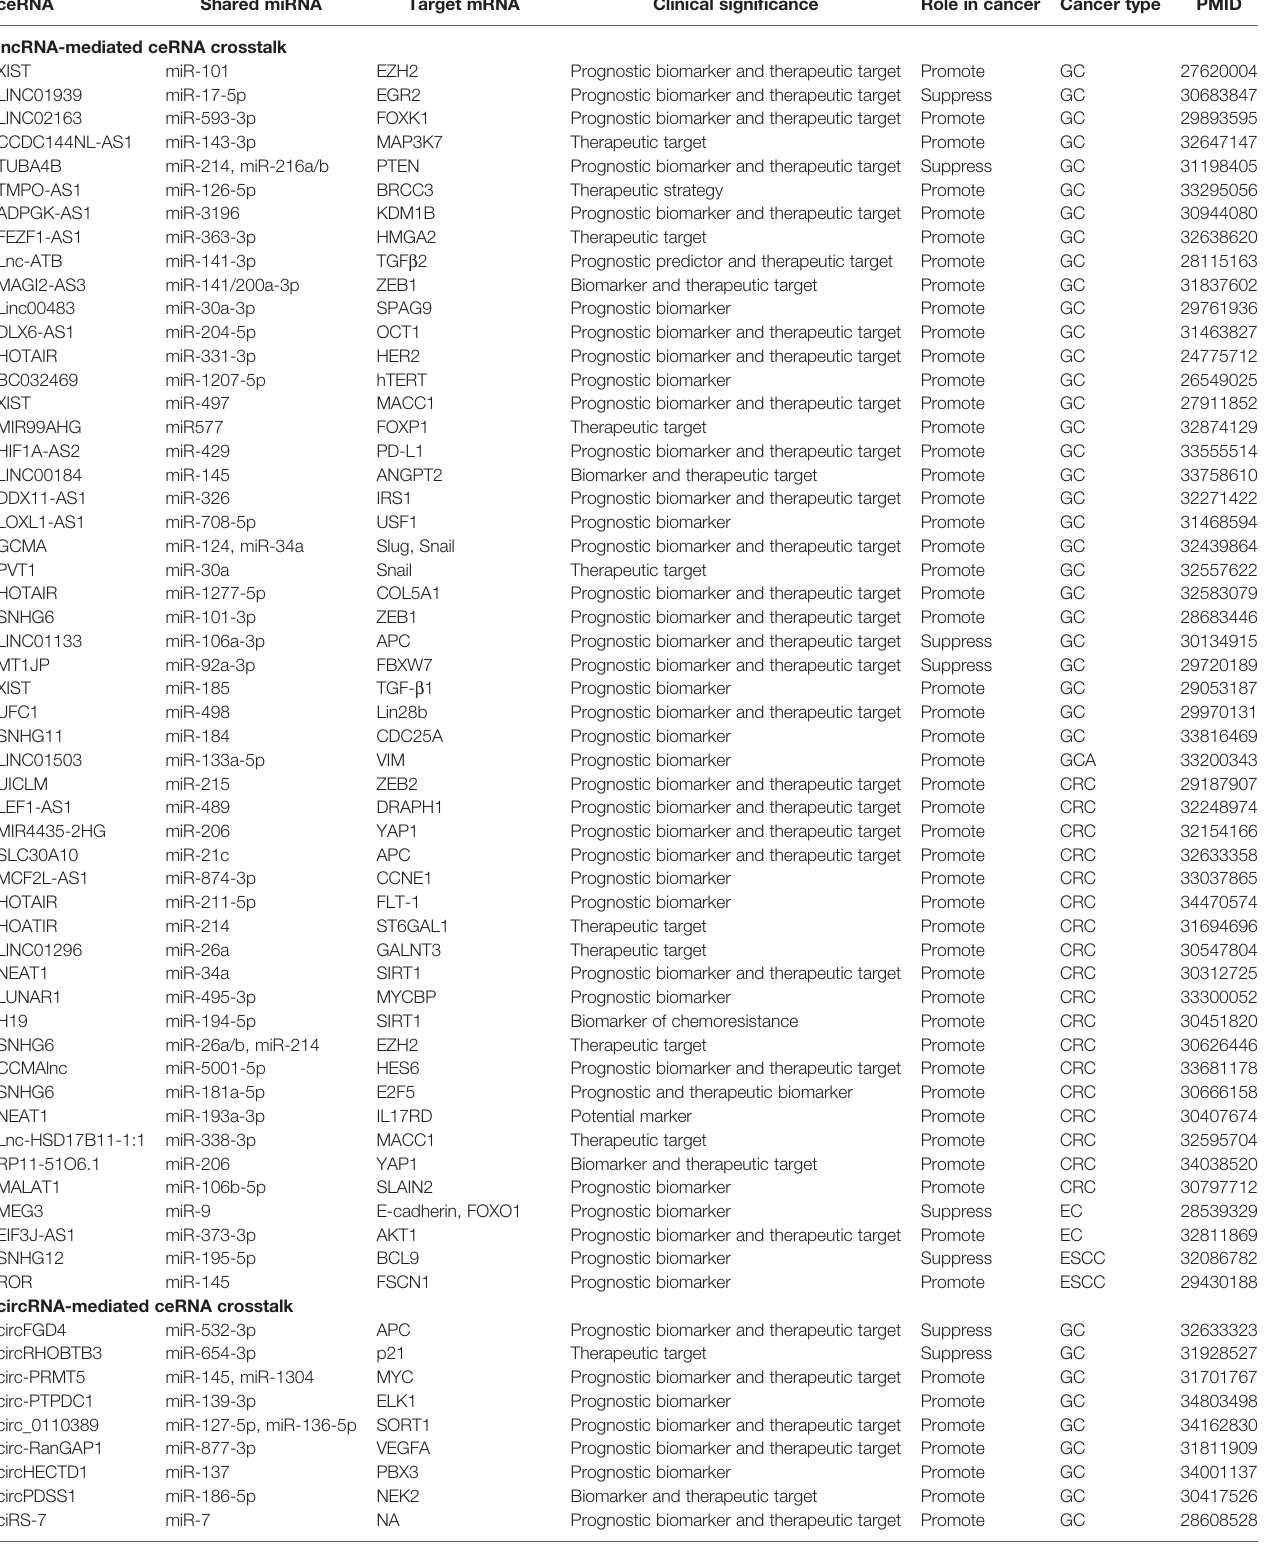
TABLE 1 | Prognostic lncRNAs and circRNAs that function by a ceRNA mechanism in GICs.